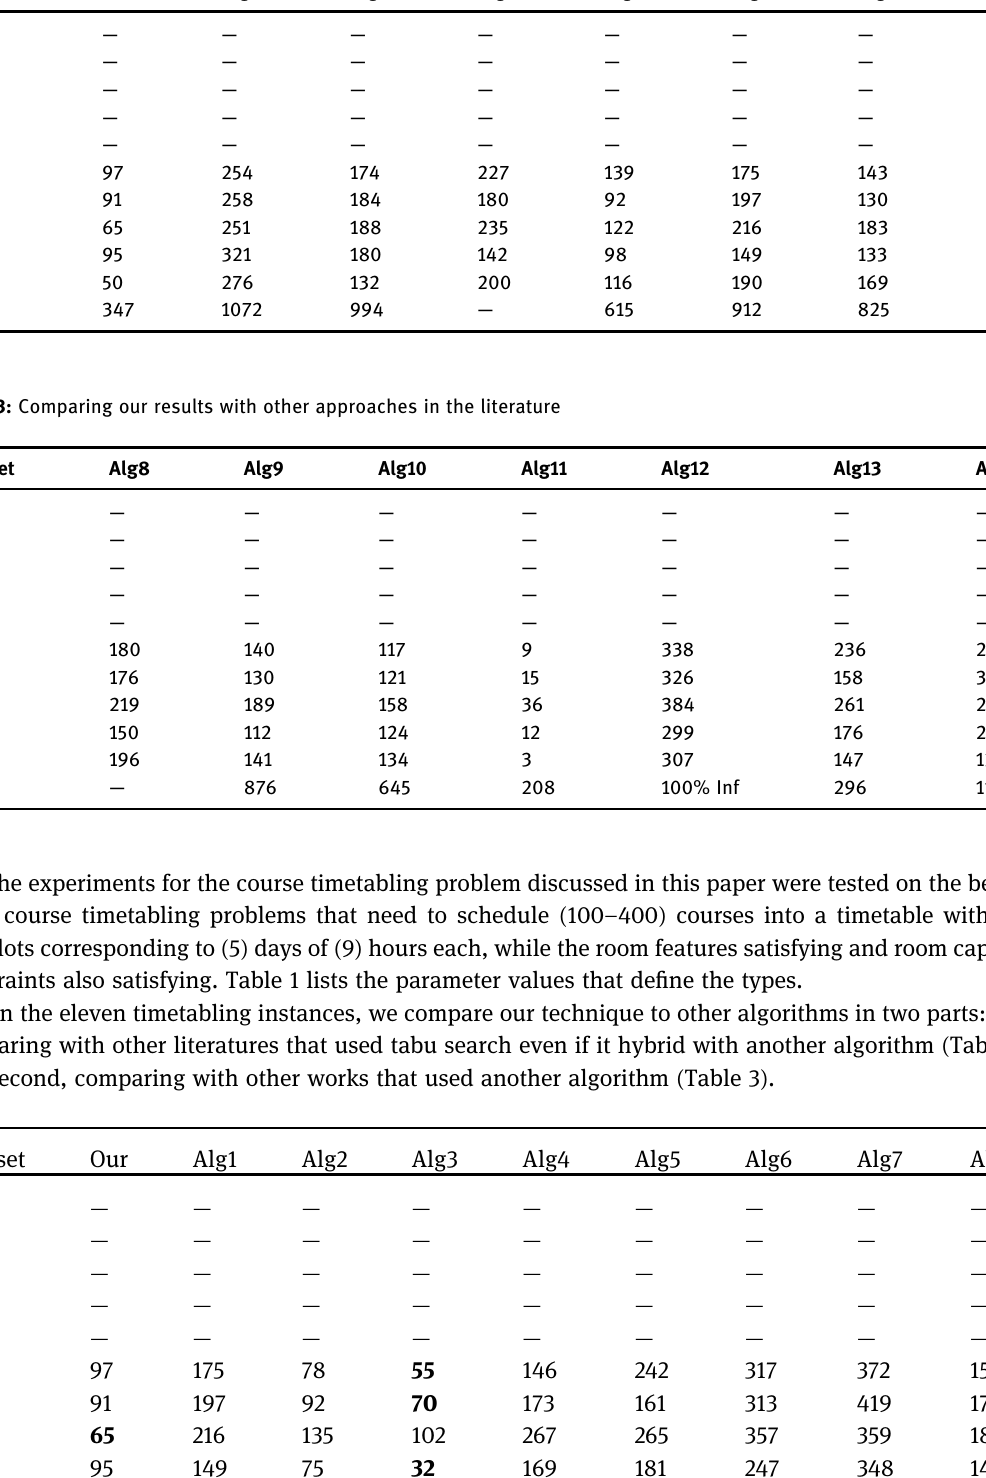
Table 2: Compare our results with the results of other tabu search Data set